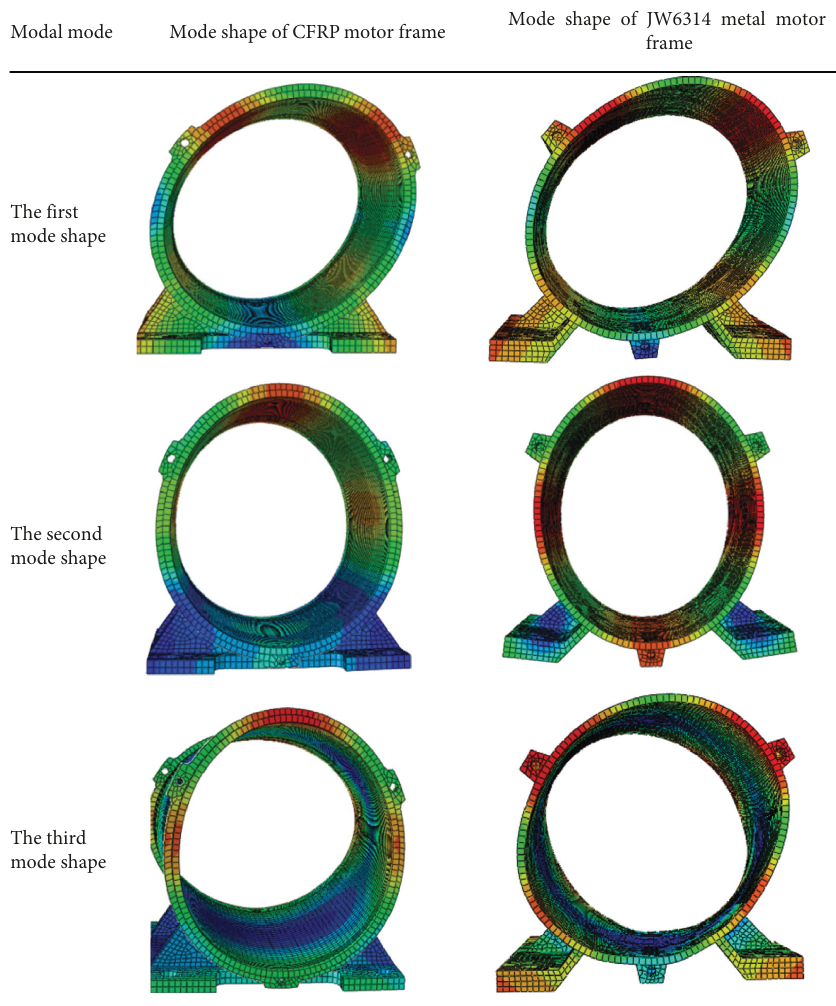
Figure 4: The first three-mode shapes of the CFRP and metal motor frame.